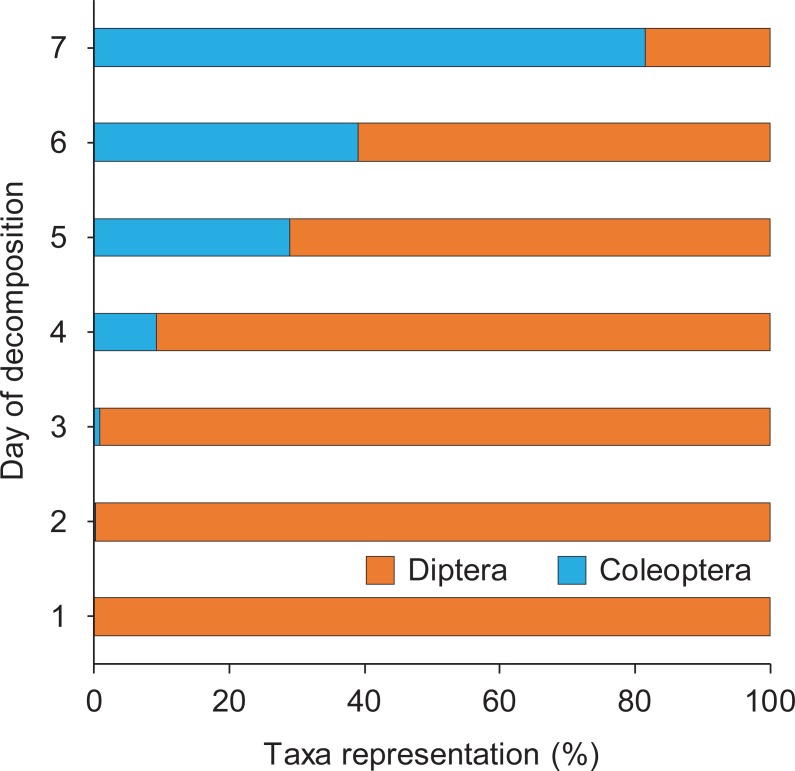
Percentage representation of dipteran and coleopteran taxa trapped or hand-collected from pigs on each day of the 7-day decomposition process.